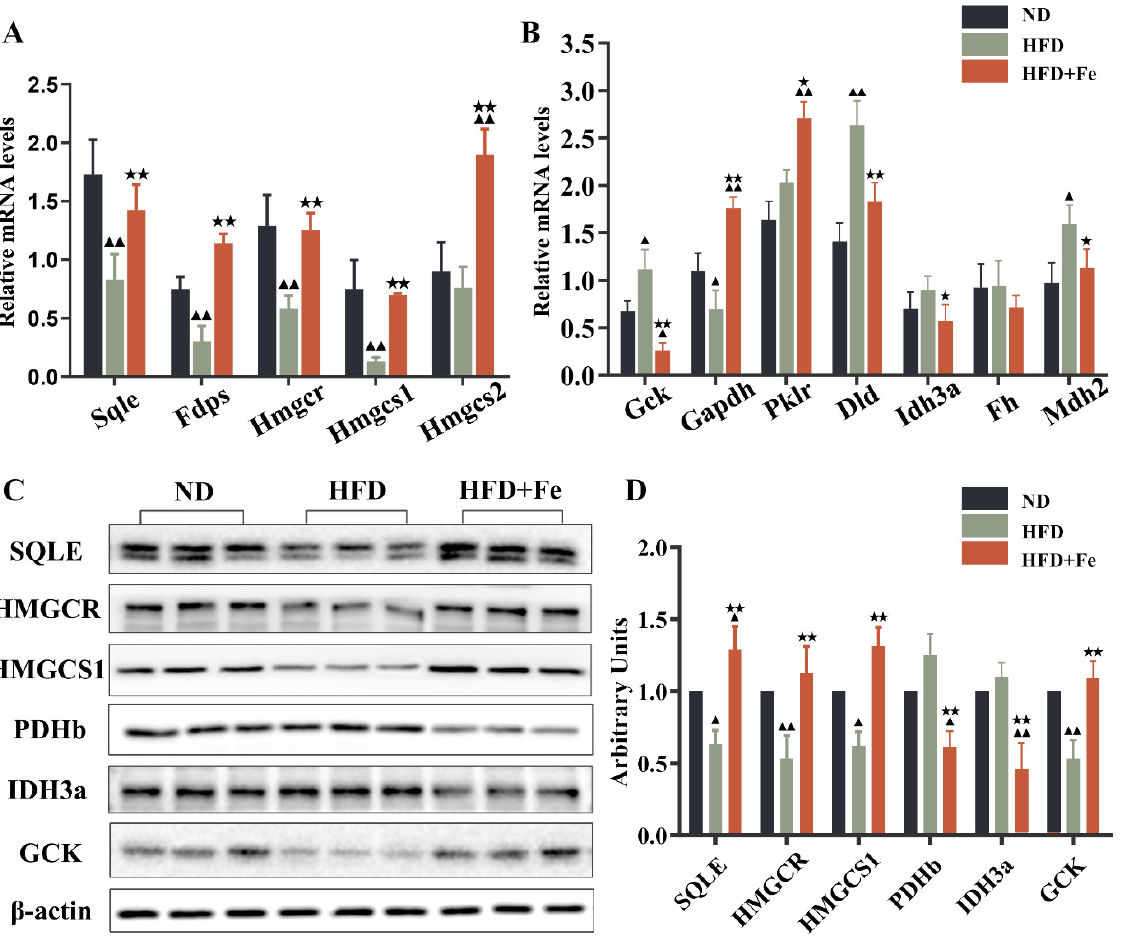
Figure 3. Validation of alterations in differentially expressed proteins. Quantitative real-time PCR ( A , B ) and Western blot analysis ( C ) were conducted to validate the alterations in representative differentially expressed proteins identified by proteomics analysis. ( D ) Quantification of ( C ). Data were expressed as the mean ± SD. ▲ p < 0.05, ▲▲ p < 0.01 vs. ND; ★ p < 0.05, ★★ p < 0.01 vs. HFD. n =